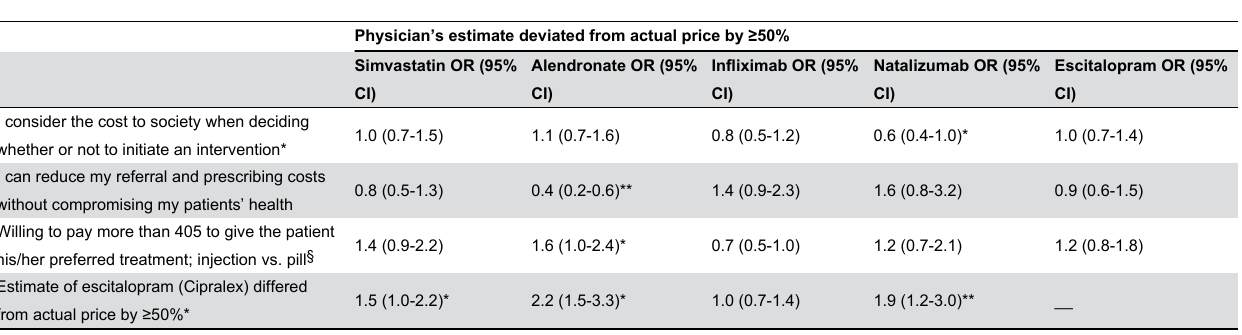
Table 3. Attitudes to costs in medical treatment as explicators for estimates deviating from actual price